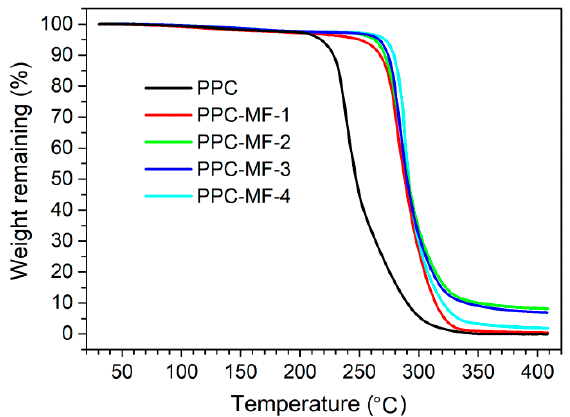
Figure 1. The TGA curves for poly(propylene carbonate) (PPC) and PPC-MFs.